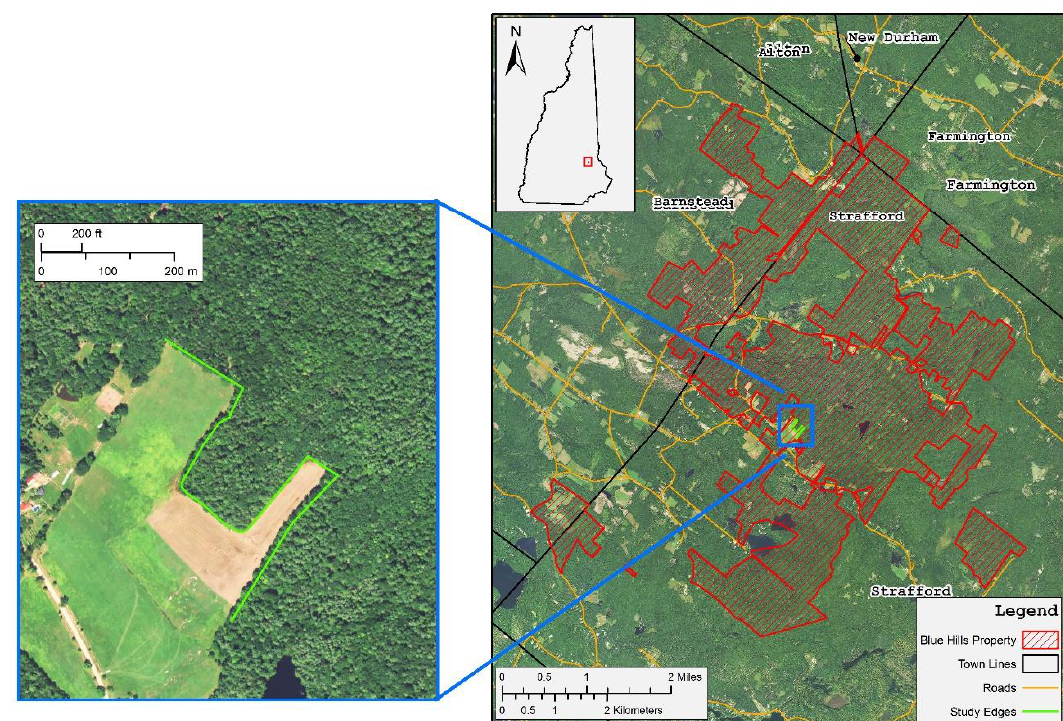
Figure 1. Study area map. The panel on the right displays the Blue Hills Foundation conservation lands. The panel on the left shows the location of the edges (the green line) investigated in this study.